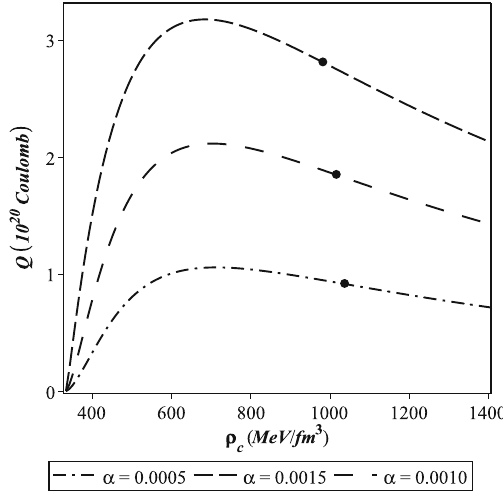
Fig. 11 Variation of Q in coulomb as a function of the central density ρ c for the strange star LMC X